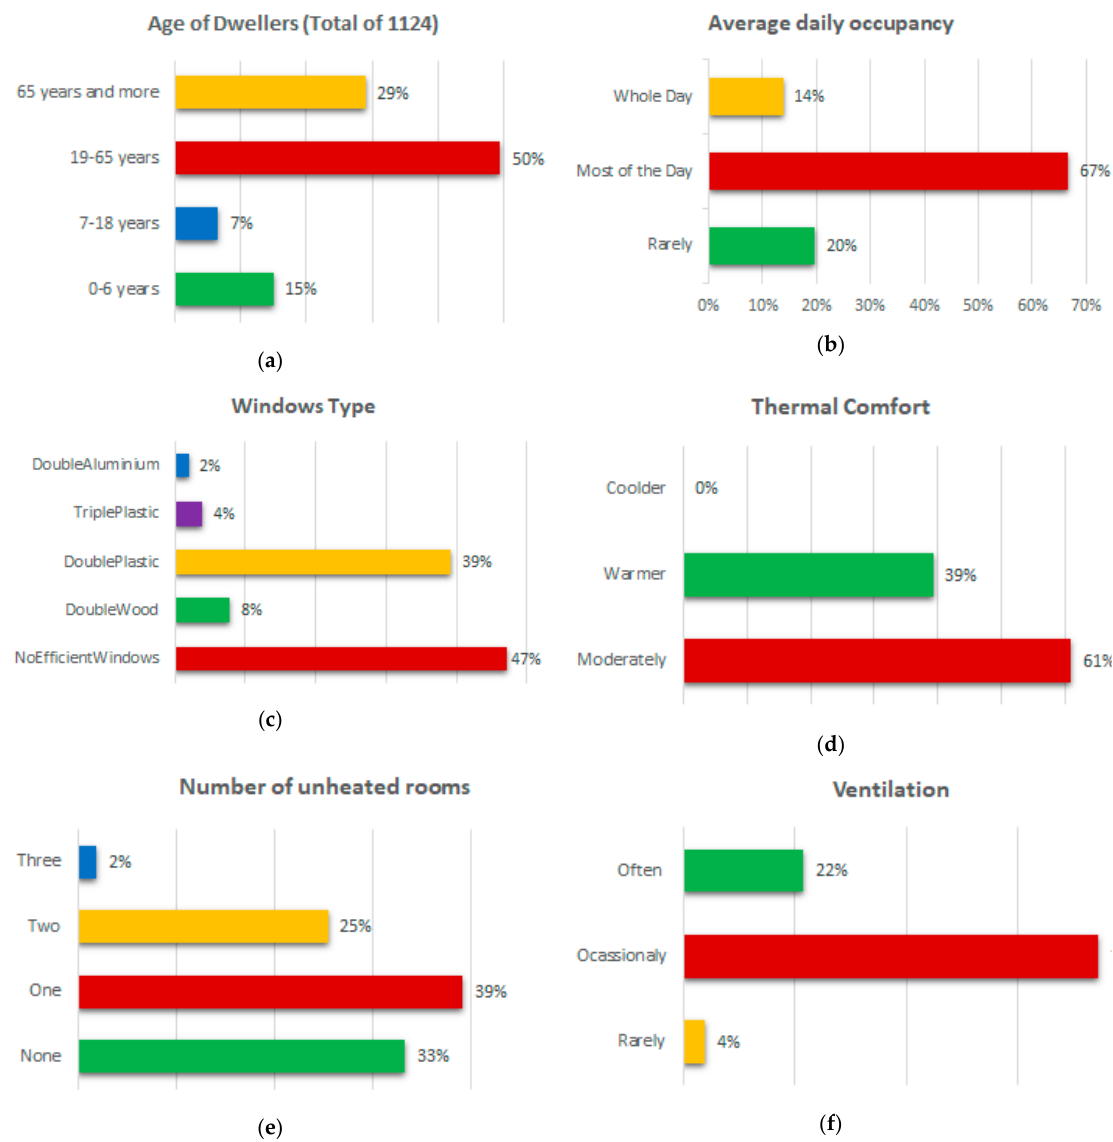
Figure 4. Results of the frequency analysis of the relevant questions from questionnaires, based on the 51 participating apartment owners: ( a ) Structure of the age of dwellers; ( b ) Daily occupancy of the analysed apartments; ( c ) Windows type; ( d ) Desired thermal comfort level; ( e ) Number of the unheated rooms; ( f ) Ventilation rate of the participating apartments.